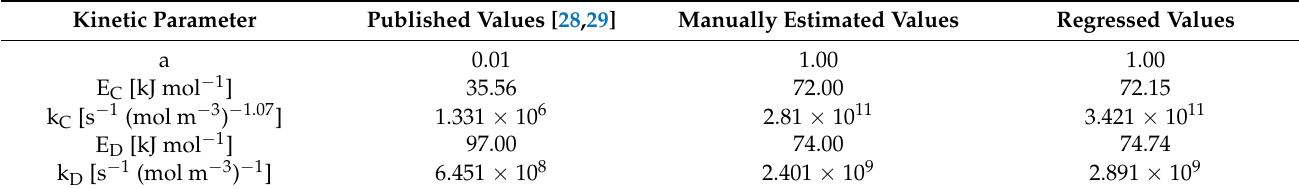
Table 1. Results of parametric estimation of selected kinetic rate constants of CO oxidation and WGS reactions (Equations (6) and (8)). Kinetic Parameter Published Values [28,29] Manually Estimated